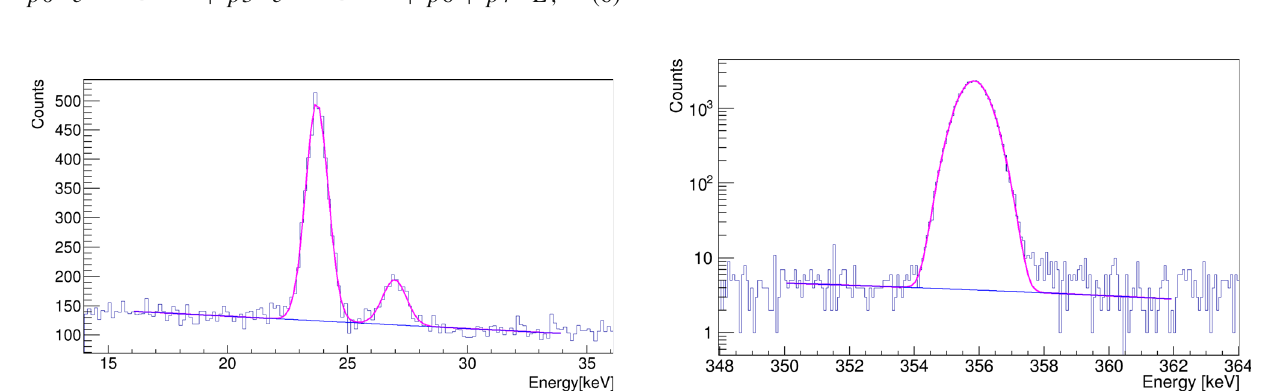
placed at the bottom of the